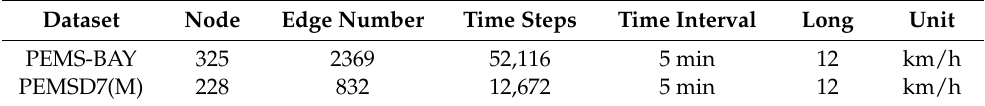
Table 1. Dataset Statistics.